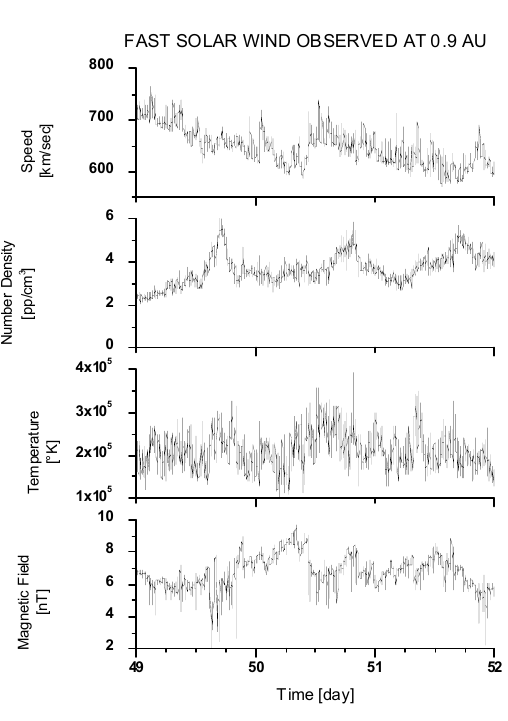
Figure 9: A sample of fast solar wind at distance 0.9 AU measured by the Helios 2 spacecraft. From top to bottom: speed, number density, temperature, and magnetic field, as a function of time.